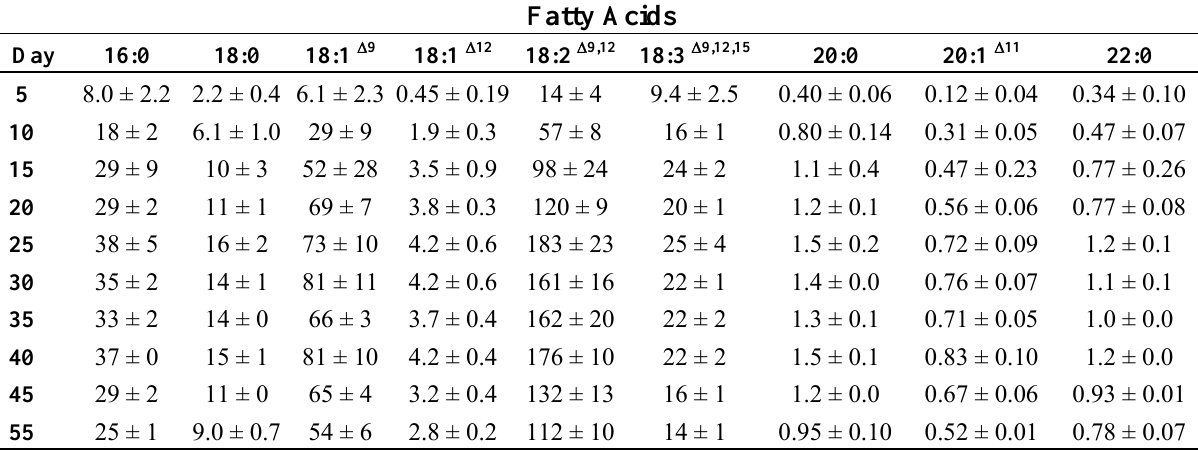
Table 1. Fatty acid levels in developing soybean embryos. Fatty acids from hydrolyzed lipids were analyzed by GC-FID as fatty acid methyl esters as described in the Experimental Section. Averages ± SD (  g mg − 1 dry weight) of three biological replicates are shown for each day in the time course. Fatty